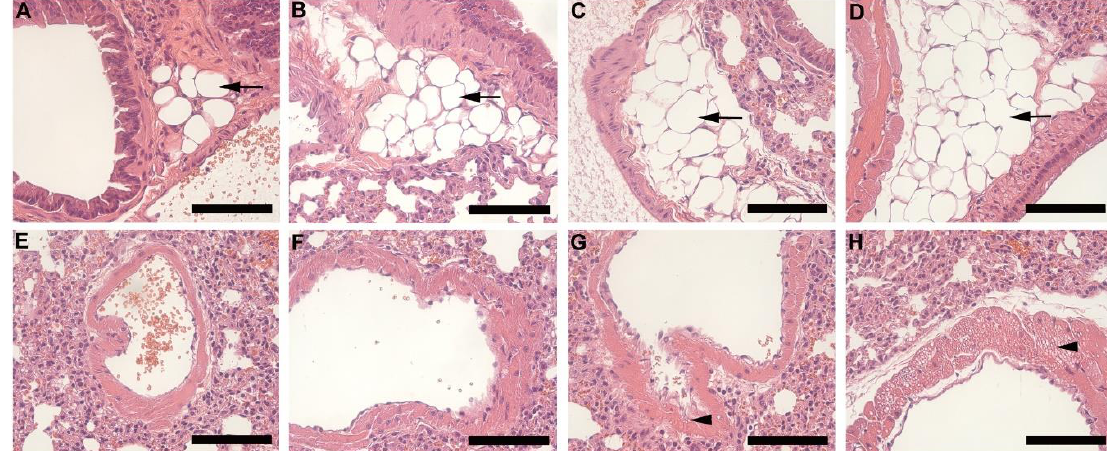
Figure 7. Histology of lung tissue harvested from animals on CD and HFD. CD females, ( A ); CD males, ( B ); HFD females, ( C ); and HFD males, ( D ); illustrates the pulmonary vasculature (bronchiole, pulmonary artery, or vein) surrounding adipocytes (black arrow). Adipocytes were larger and more prominent in the HFD groups ( C , D ) than CD ( A , B ). The pulmonary artery of CD females, ( E ); CD males, ( F ); HFD females, ( G ); and HFD females, ( H ); shows lipid accumulation (arrowhead) in the smooth muscle layer, which was evident in the HFD groups ( G , H ), particularly in HFD males, ( H ). Scale bar: 100 µm .